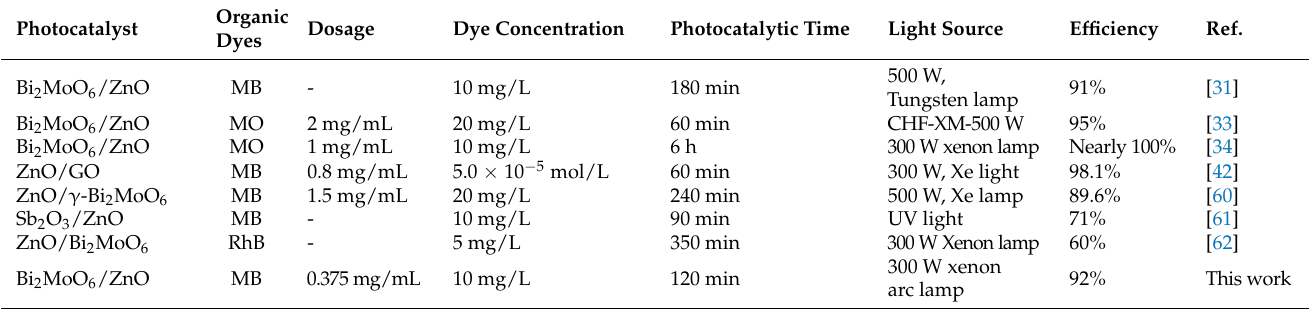
Table 3. Comparison of photocatalytic performance.